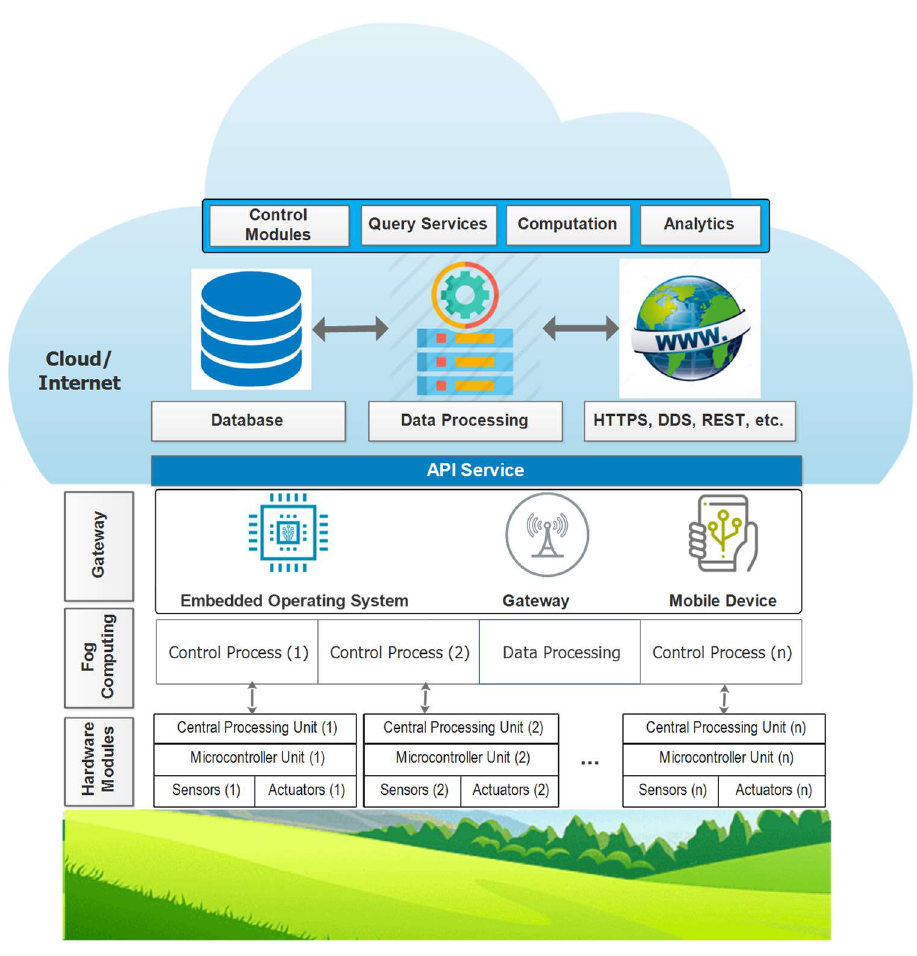
Figure 6. Cloud-assisted IoT-based precision agriculture platform.